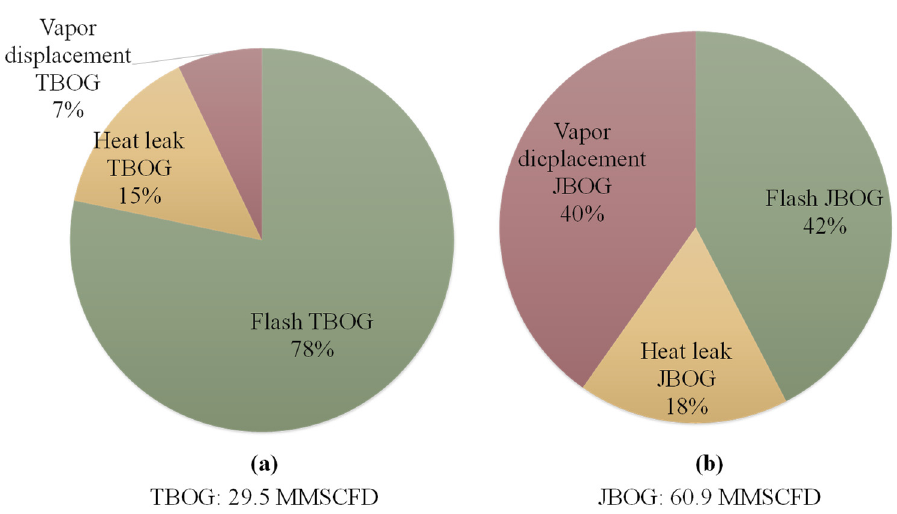
Figure 1. BOG distribution by source, ( a ) during holding mode, ( b ) during loading mode.